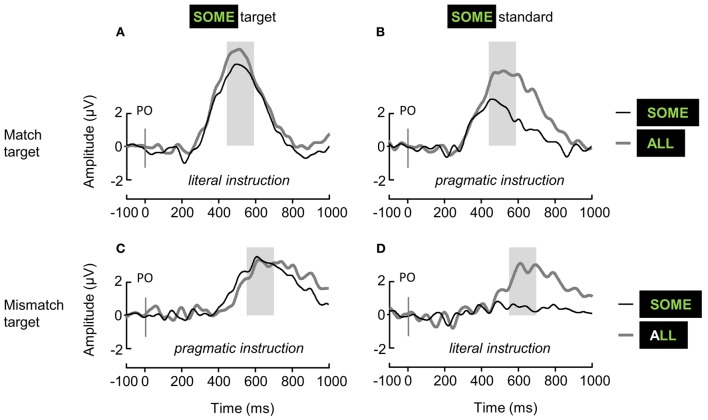
Grand-average difference ERP waveforms elicited over the Parieto-Occipital region (linear derivation of Pz, PO3, PO4, POz) by unambiguous target-ALL (gray lines), and ambiguous-SOME (black lines), depending on the Block type (A,B, match target; C,D, mismatch target), and the status of ambiguous-SOME (A,C, target; B,D, standard). In italics: the context of interpretation of ambiguous-SOME. The shaded areas represent the time-windows used for the analysis of P3b effects.